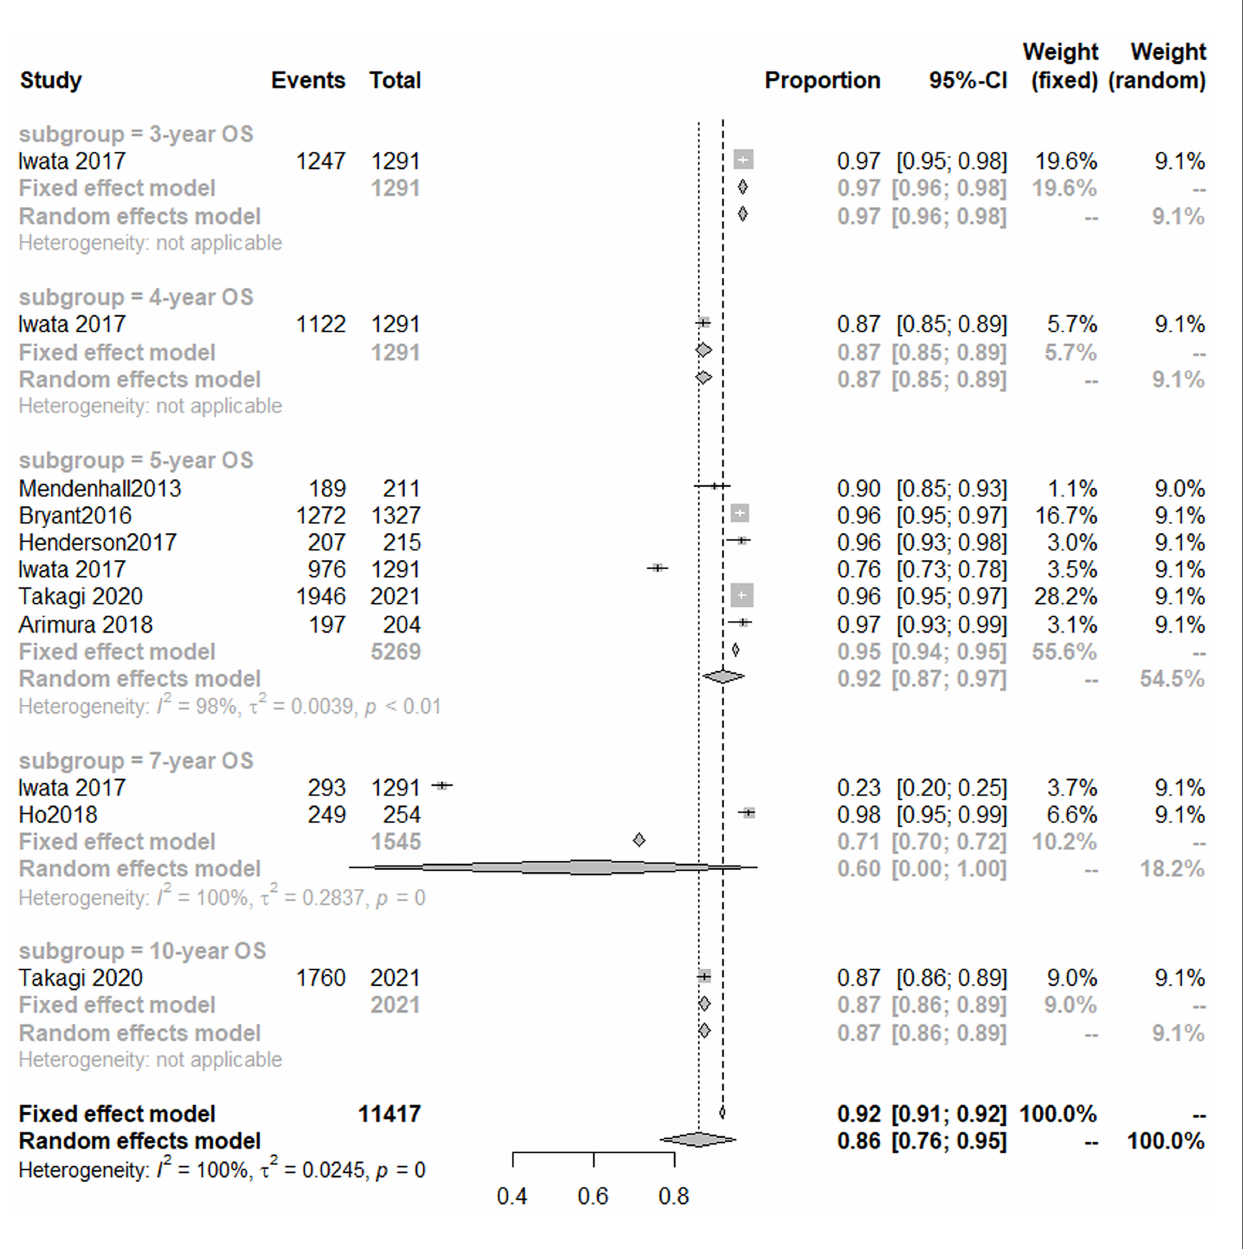
FIGURE 4 | Overall survival rate of protons radiotherapy for prostate